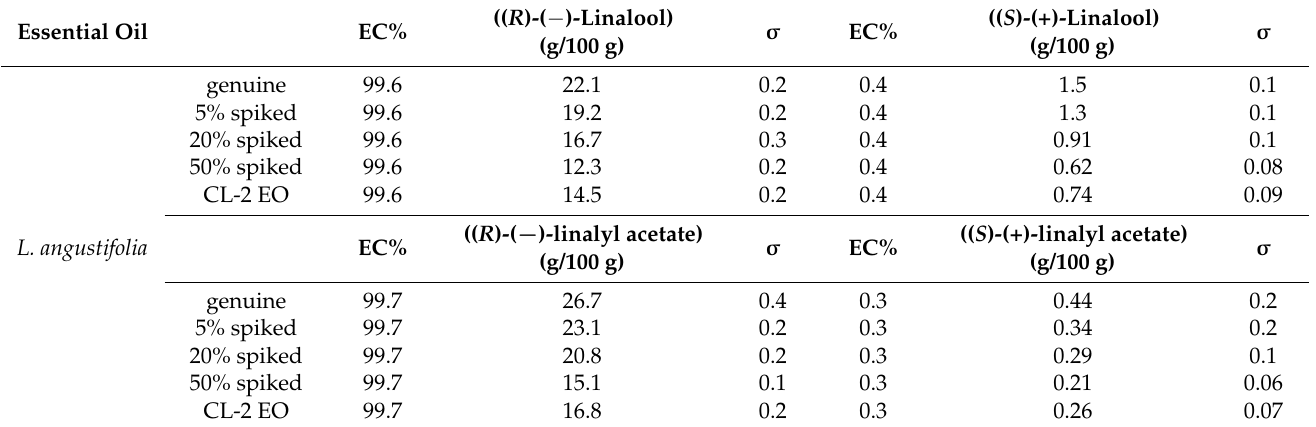
Table 5. Absolute concentrations of the enantiomers of linalool and linalyl acetate in both genuine and vegetable oil-spiked CL-2 EO.